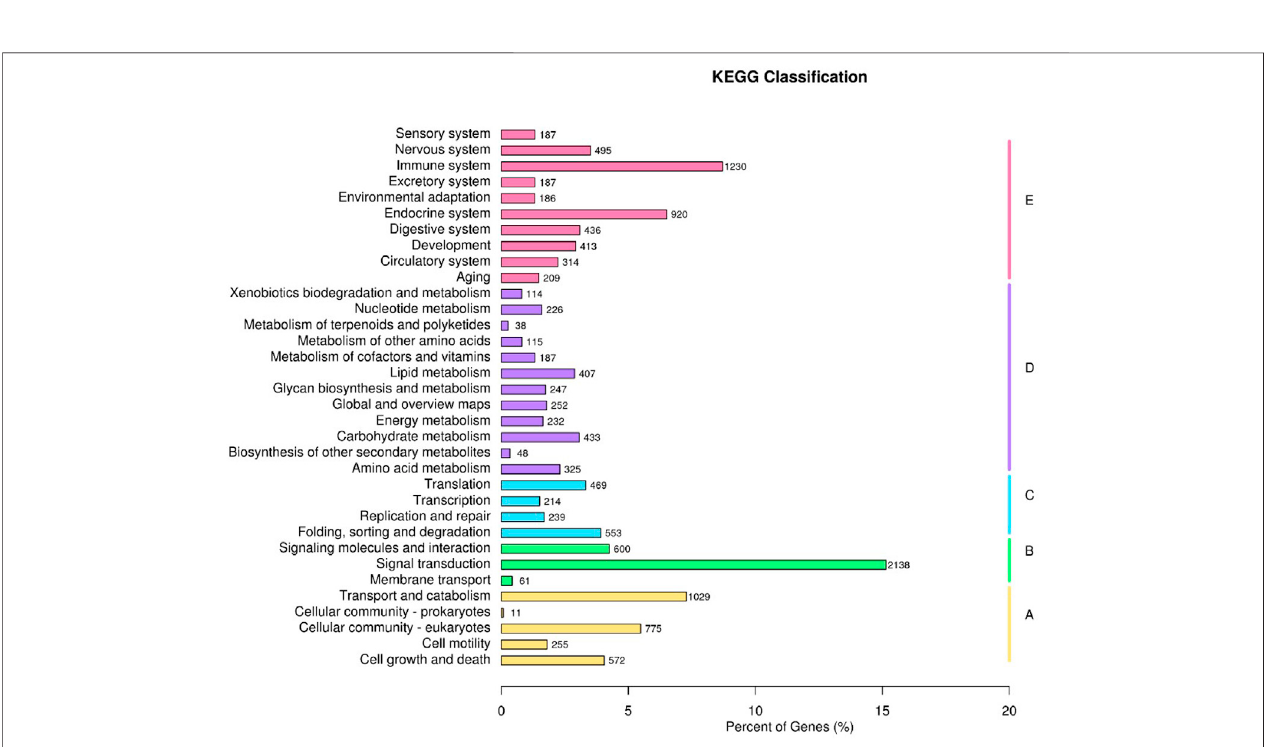
FIGURE 6 | KEGG functional classi fi cations. (A) Cellular Processes, (B) Environmental Information Processing, (C) Genetic Information Processing, (D) Metabolism, (E) Organismal Systems.